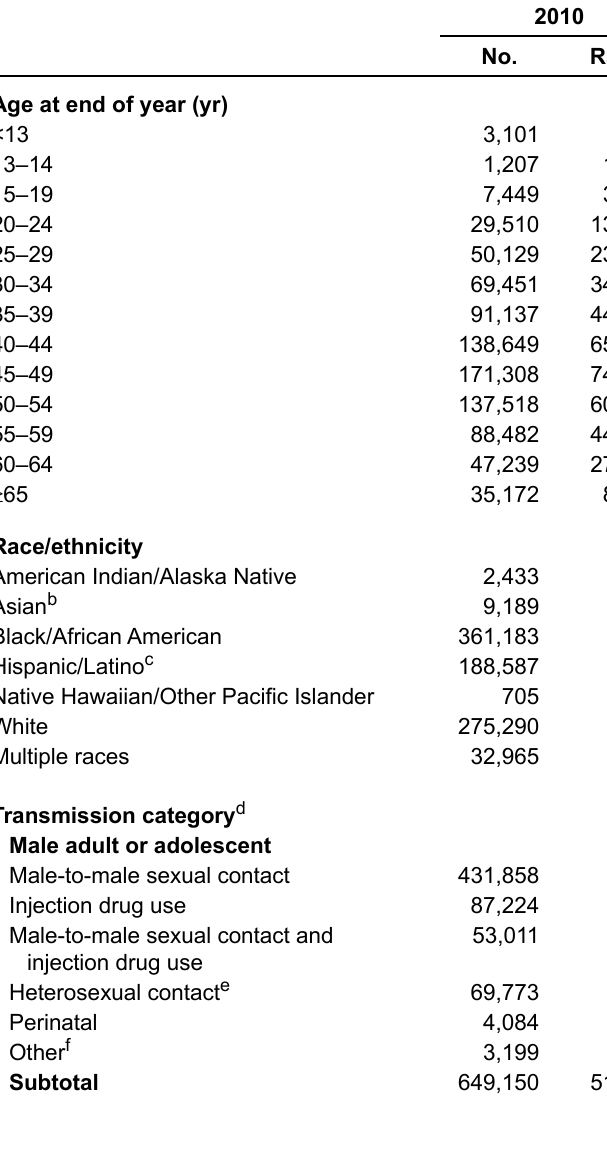
Table 18b. Persons living with diagnosed HIV infection, by year and selected characteristics, 2010–2014—United States and 6 dependent